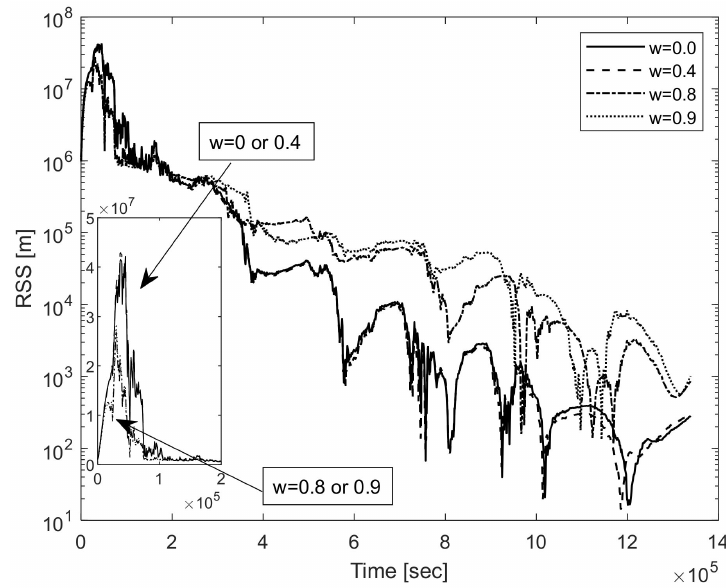
Figure 13. Sample navigation errors for typical tradeoff